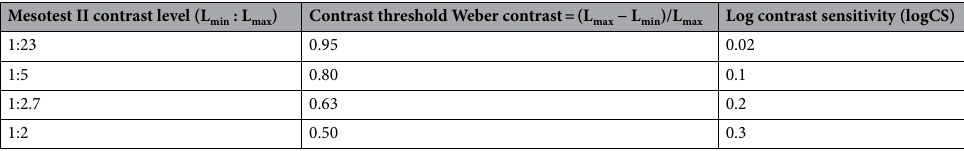
Table 1. Mesotest II contrast levels as proposed by manufacturers expressed in logCS. L min : Luminance for darker region, L max : Luminance for brighter region.